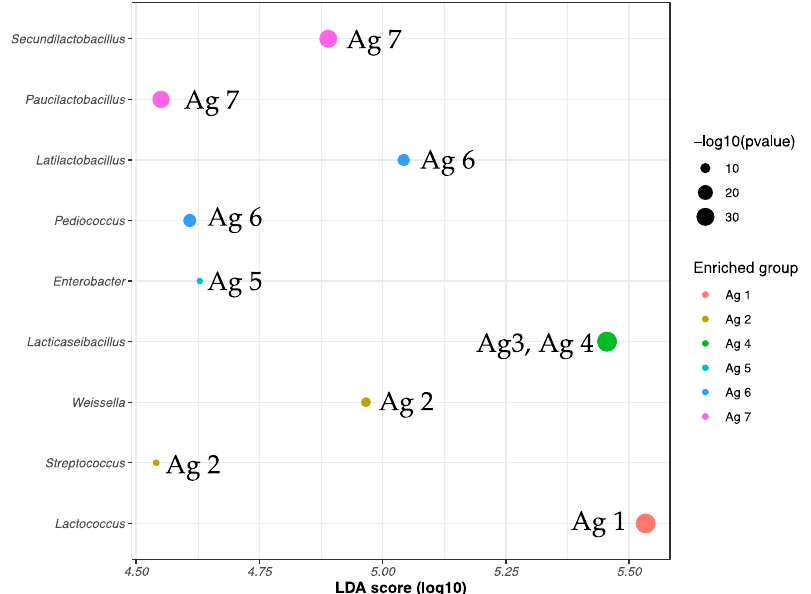
Figure 9. Linear discriminant analysis (LDA) of ASV abundance obtained from DNA extracted from PMA-treated bacterial cells of Cheddar cheese belonging to six out of seven ripening age categories sampled over 13 trials. Age 3 gave the same ASV biomarker as age 4 cheese microbiota.